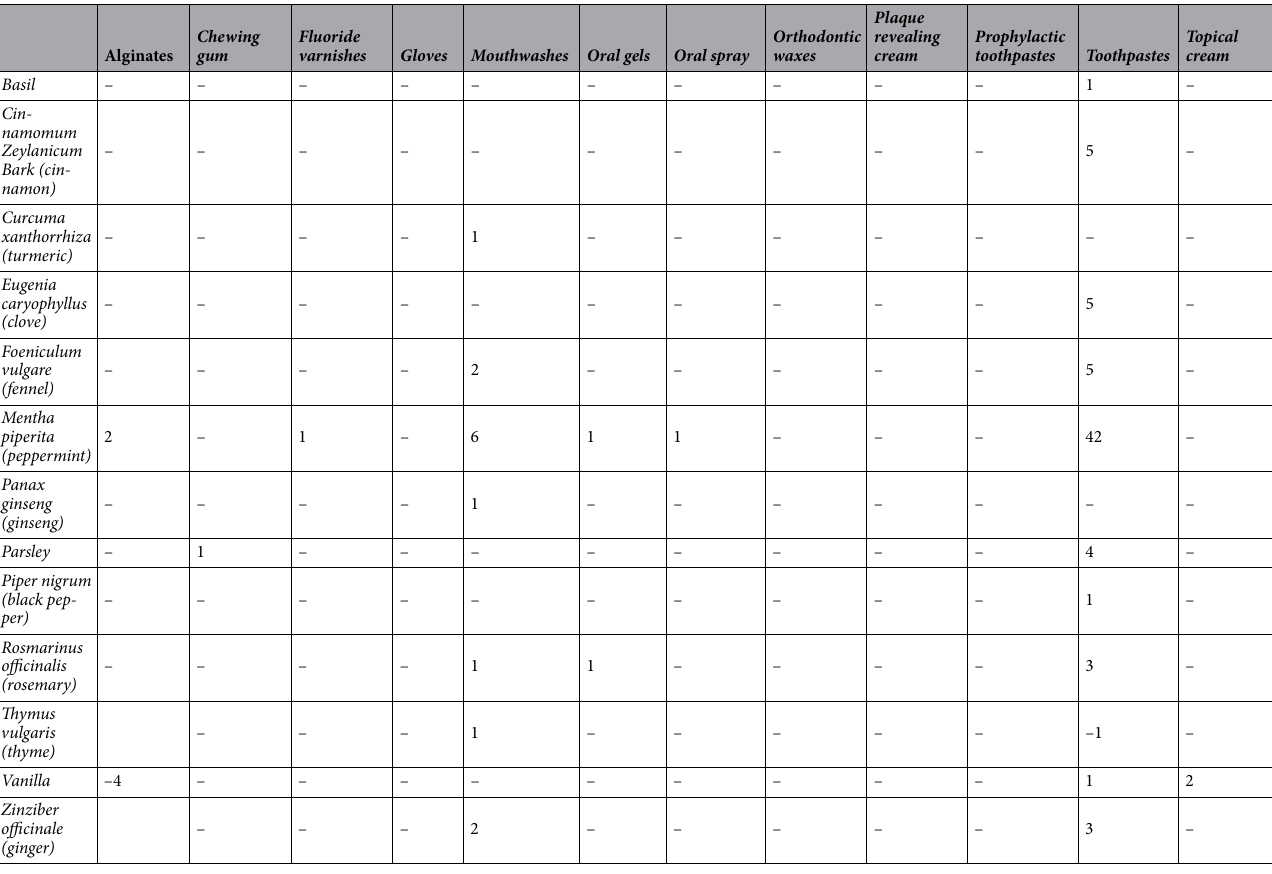
Table 5. Spices in the studied OCP